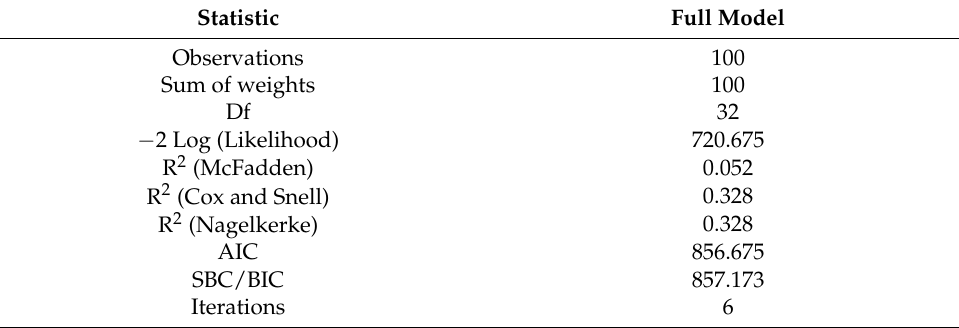
Table 2. Goodness of fit statistics for intraherd hierarchy status model.